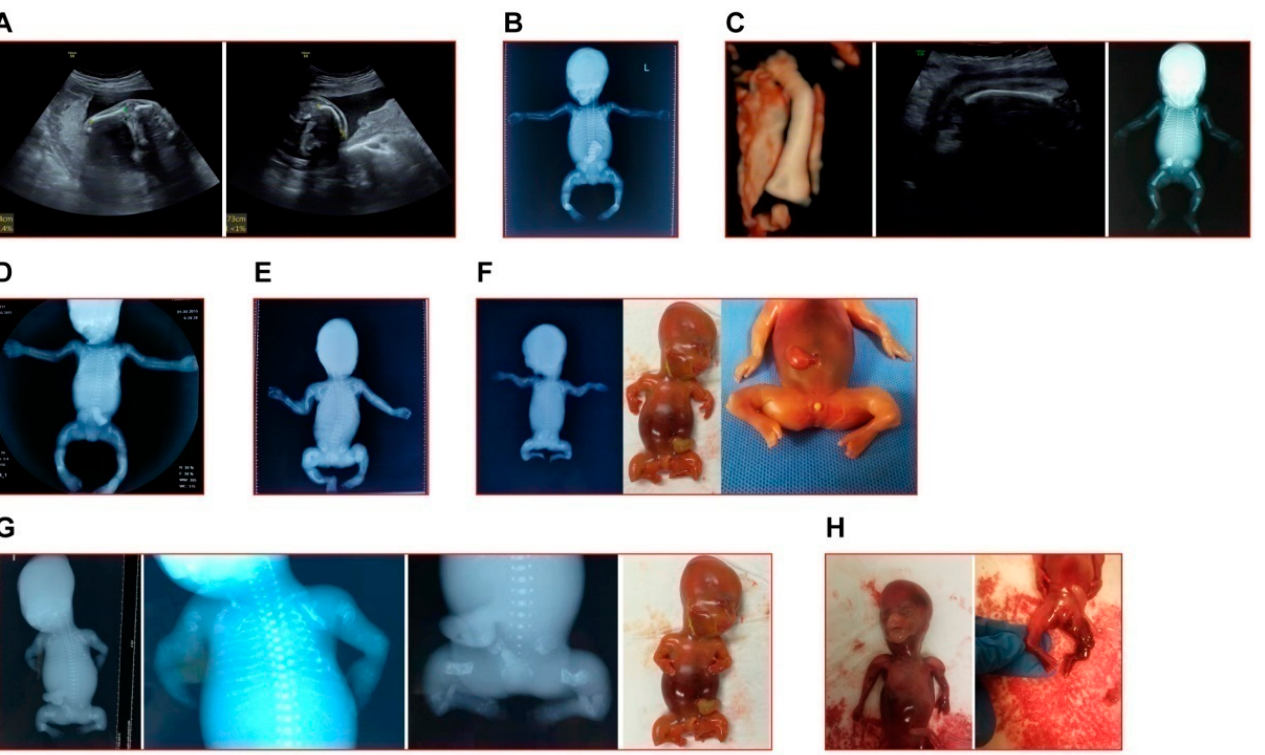
Figure 1. The representative clinical images of fetuses in this study. ( A ) The left humerus (left image) and right femur (right image) of fetus in Case 1 appeared curved at angled. ( B ) The X-ray image of induced fetus in Case 2 showed typical OI indications (short and curved femur, tibia and fibula). ( C ) Case 3: left and middle, the 3D reconstruction of the curved femur and the in utero curve of femur of the second fetus; right, the X-ray image of the first induced fetus in this family. ( D ) The X-ray image of induced fetus in Case 5. ( E ) The X-ray image of induced fetus in Case 6. ( F ) The X-ray image (left) and appearance (middle and right) of induced fetus in Case 7. ( G ) The X-ray images and appearance (farthest to the right) of induced fetus in Case 8. ( H ) The appearance of induced fetus in Case 9. Note: In accordance with the wishes of the affected families, clinical images of Cases 4 and 10 are not shown.